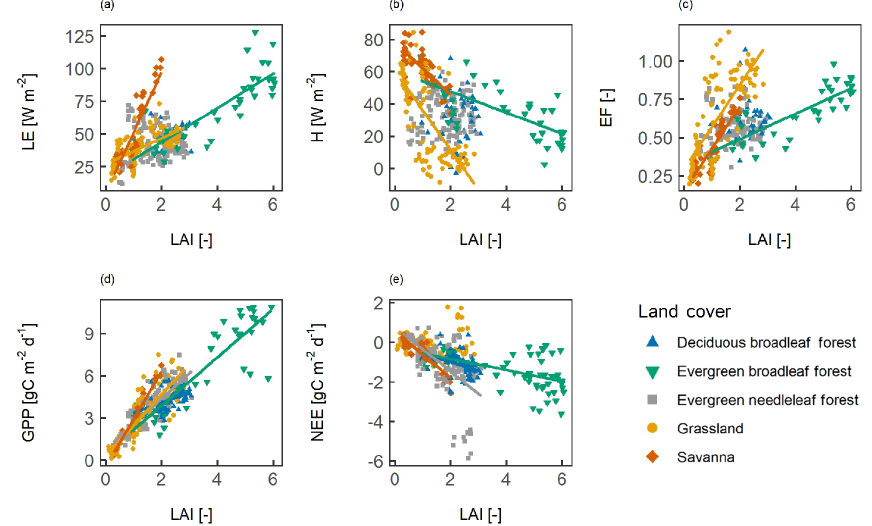
Figure 4. The spatio-temporal correlation between surface fluxes and leaf area index (LAI). Panels show (a) the latent heat flux ( LE ), (b) the sensible heat flux ( H ), (c) the evaporative fraction (EF), (d) gross primary productivity (GPP), and (e) net ecosystem exchange (NEE). A line indicates a significant correlation at p< 0 . 05.